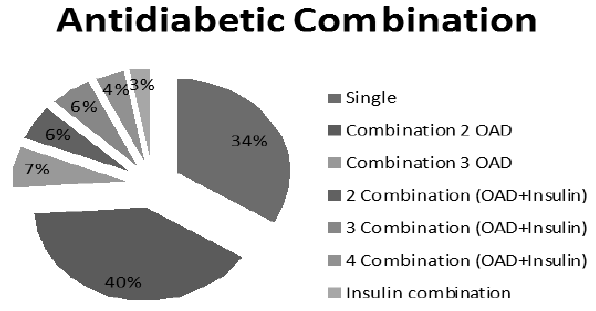
Figure 1. Percent of single and combination of antidiabetes drug in geriatric outpatients Dr. Soetomo